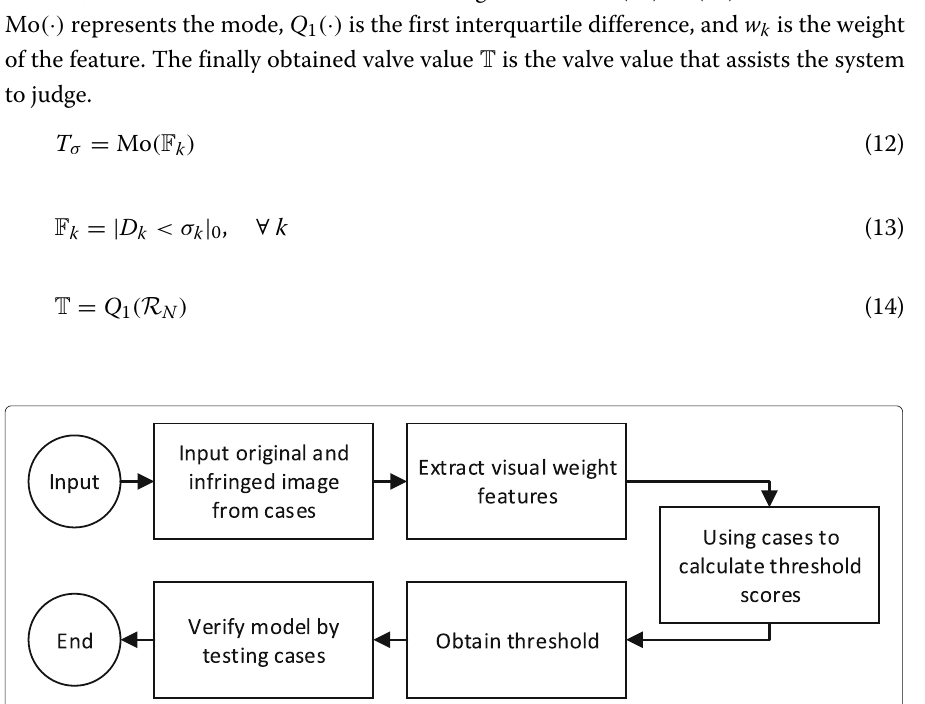
Fig. 2 Proposed the implementation flow chart of proposed trademark similarity comparison